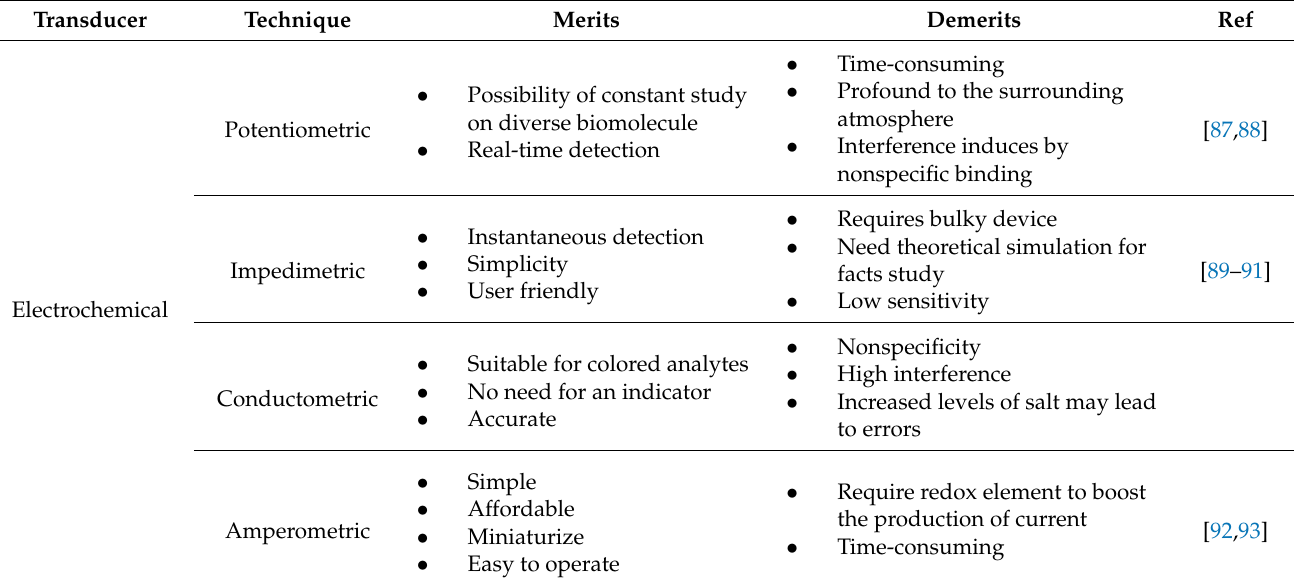
Table 1. Summary of different techniques of electrochemical